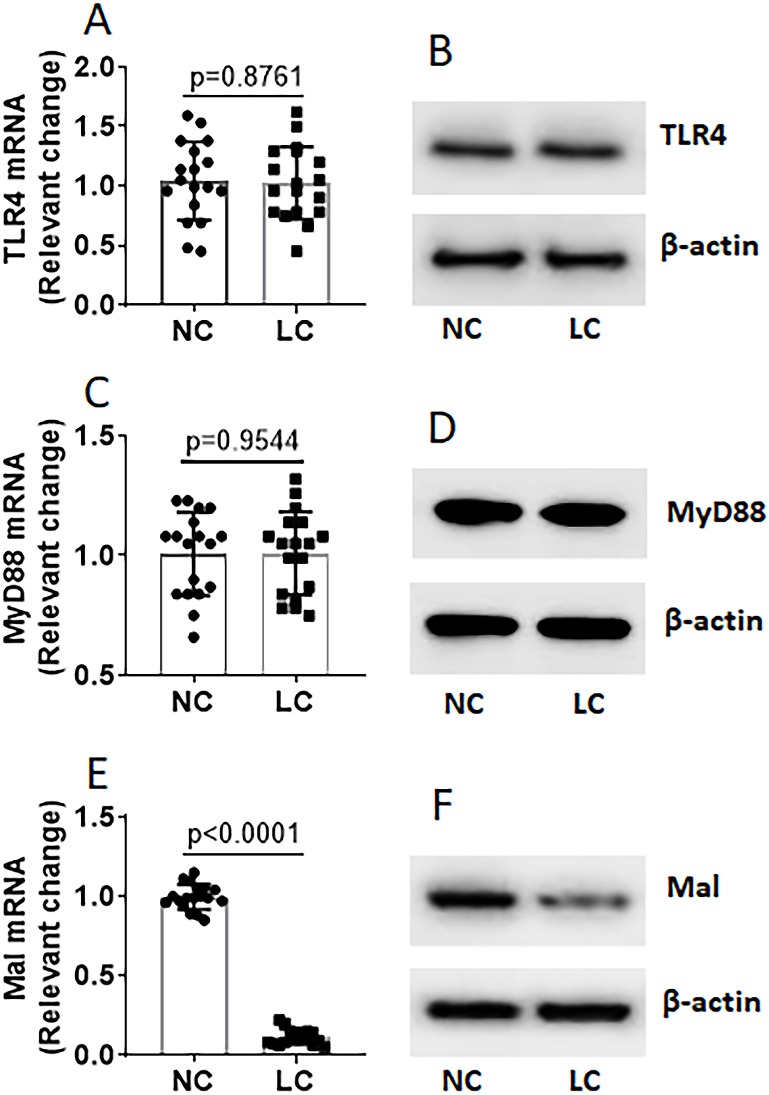
LC cells express less Mal.LC tissue was collected from LC patients (n = 18). LC cells and NC cells were isolated and analyzed by RT-qPCR and Western blotting. A-B, levels of TLR4. C-D, levels of MyD88. E-F, levels of Mal. Data of bars are presented as mean ± SEM. Each dot in bars presents data obtained from one sample. Statistics: t test.